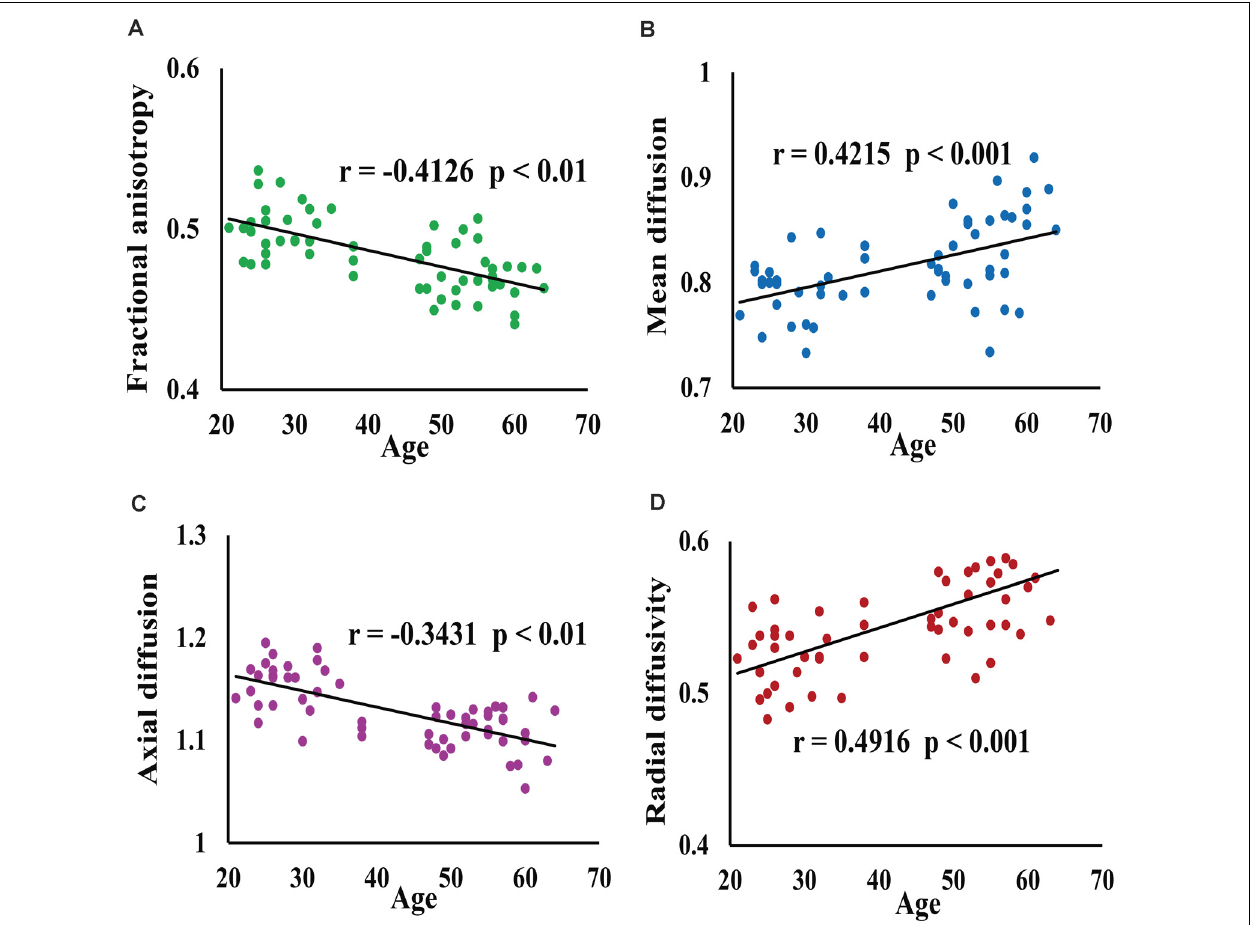
FIGURE 2 | This figure shows the results of correlation between age and average white matter microstructure parameters (FA, MD, AD, RD) of all voxels in clusters. Panel (A) represents FA value, (B) represents MD value, (C) represents AD value, (D) represents RD value; where (B) , (C) and (D) ordinates expand 10 3 times. The scatter plot of FA (A) and AD (C) of voxels with age showed that age was negatively correlated with FA and AD, while the scatter plot of MD (B) and RD (D) with age showed that age was positively correlated with MD and